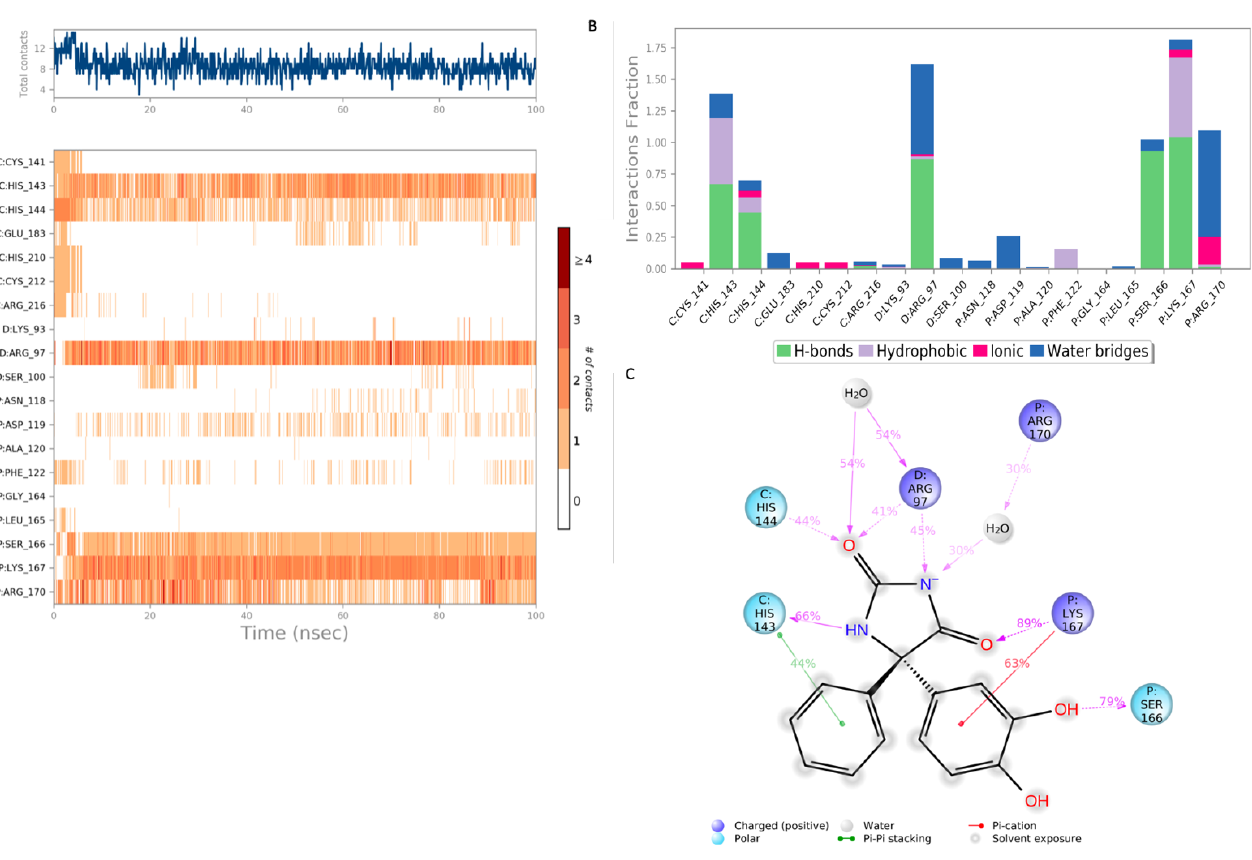
Figure 8. ( A ) Olsalazine, ( B ) phlorofucofuroeckol and ( C ) phenytoin catechol, docked in the GTPCH1-binding pocket. All bonds are depicted as dotted lines: hydrogen bonds — yellow; salt